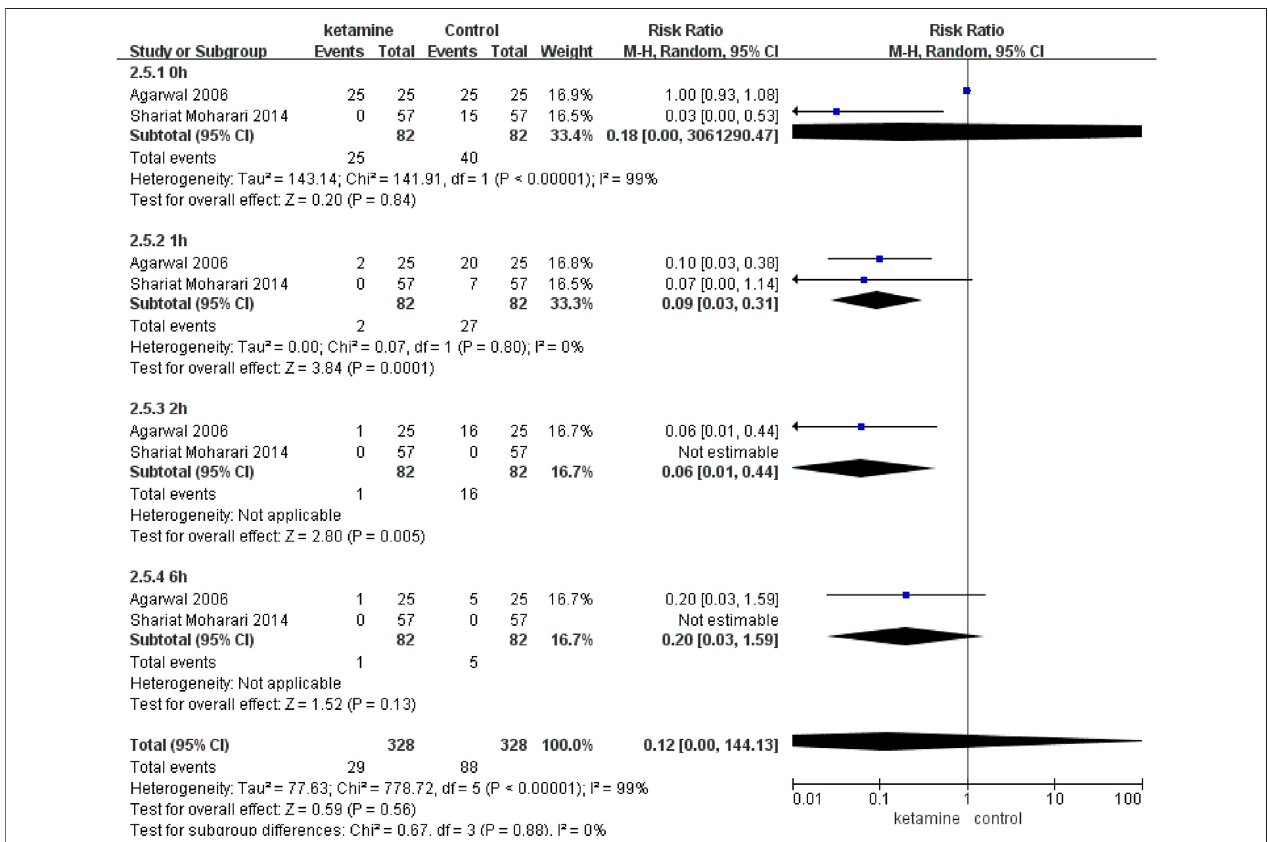
FIGURE 5 | Incidence of moderate-to-severe catheter-related bladder discomfort in ketamine vs. placebo.